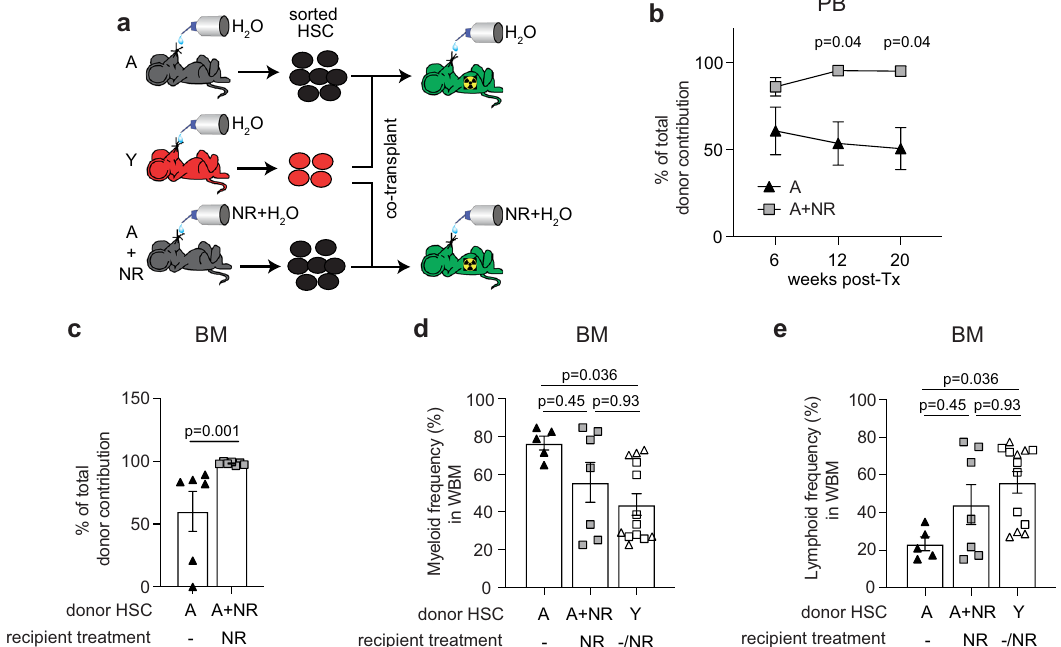
Fig. 7 NR administration signi fi cantly improves HSC reconstitution potential of aged HSC. a Schematic representation of the experimental set up for the competitive transplant experiment. b Quanti fi cation of the percentage of aged ( n = 6, biological replicates) and NR-treated aged ( n = 7, biological replicates) donor cells relative to total donor-derived CD45 + hematopoietic cells in PB of young recipient mice at 6, 12, and 20 weeks and c BM at 20 weeks following transplantation. Data are mean ± s.e.m. and are representative of a single experiment. Statistical analysis was performed using two-way ANOVA with Geisser-Greenhouse correction, p = 0.01 (overall for treatment factor) with individual groups for each timepoint compared using Holm – Sidak multiple comparisons test, p -values indicated for b and two-sided Mann – Whitney U -test for c . d , e Quanti fi cation of the frequency of aged ( n = 5, biological replicates), NR-treated aged ( n = 12, biological replicates. Circle symbols refer to untreated recipients and square symbols refer to NR-treated recipients) d myeloid cells (Gr1/Mac-1 + ) and e lymphoid cells (B220 + , CD3 + ) in BM of recipient mice 20 weeks after transplantation. For recipients where <0.01% engraftment of the relevant cell population was observed, no lineage analysis was performed. Data are mean ± s.e.m. and statistical analyses were performed using Kruskal – Wallis, p = 0.042 (overall) with individual groups compared using Dunn ’ s multiple comparisons test, p-values indicated for ( d , e ). Triangle symbols refer to untreated recipients and square symbols refer to NR-treated recipients. BM bone marrow, WBM total bone marrow, HSC hematopoietic stem cells, NR nicotinamide riboside, PB peripheral blood, Y young, A aged, A + NR NR-treated aged animal. Source data are provided as a Source Data